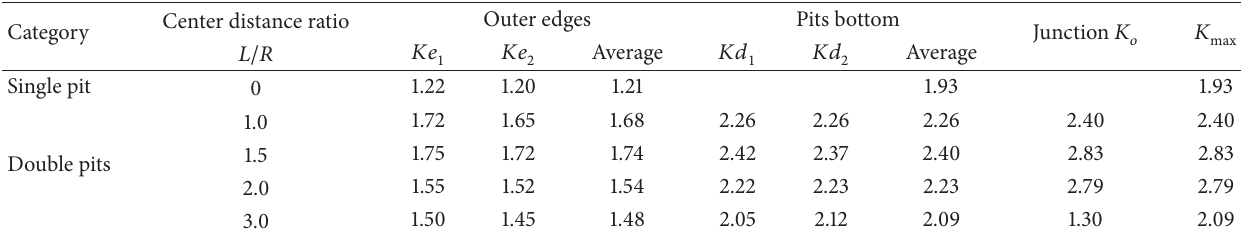
Figure 7: Shallow-spherical double pits stress concentration photoelastic experiment model. Table 1: Results of photoelastic experiment.